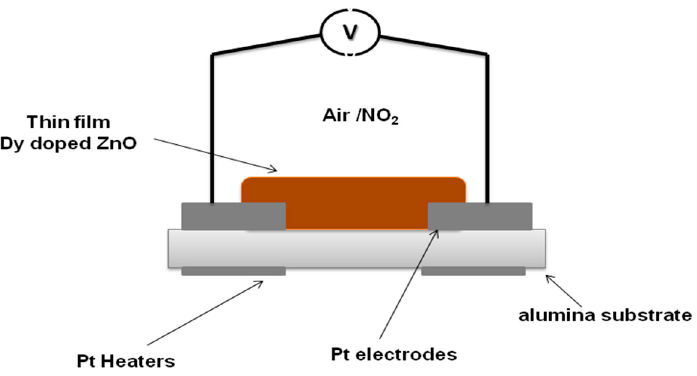
Figure 1. Structure of the gas sensing device.